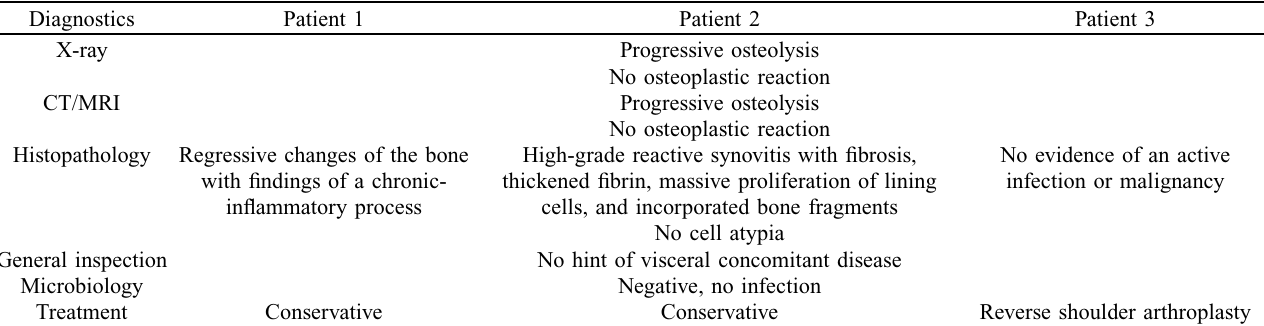
Table 1. Diagnostic results and treatment regimes of the three patients suffering Gorham-Stout